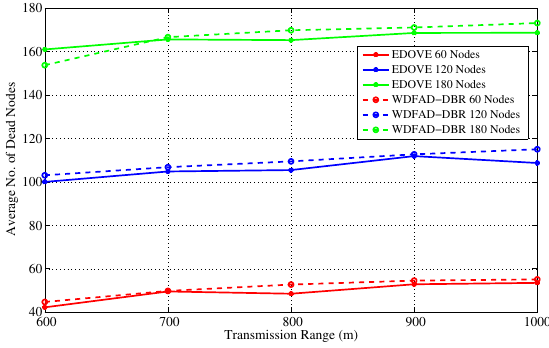
Figure 16. Number of dead nodes versus different transmission ranges.